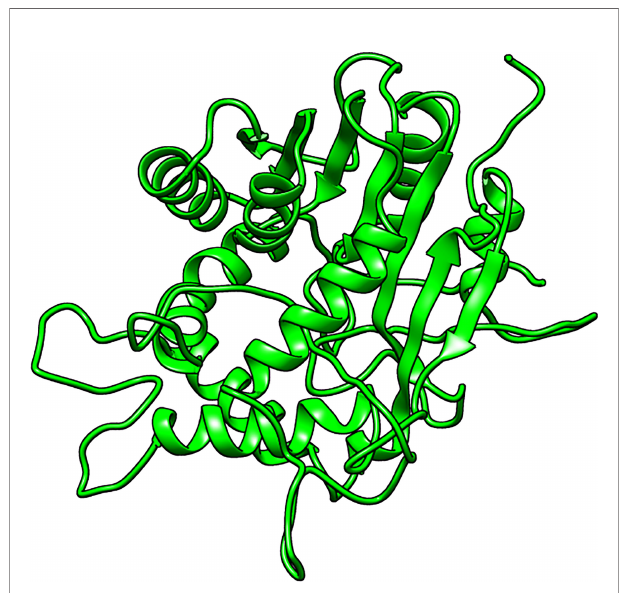
FIGURE 2 | Cartoon representation of the structure of the selected Leishmania donovani 24-sterol methyltransferase ( Ld SMT) model